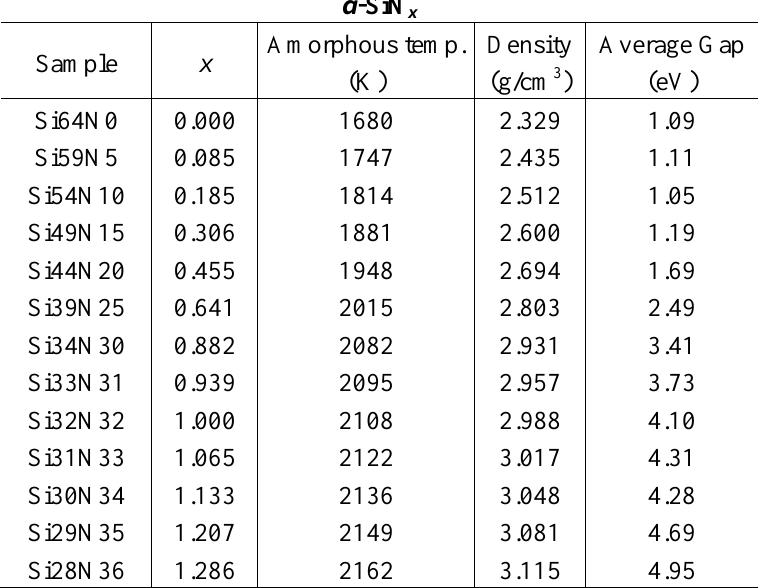
Table 2. Characteristics of 13 samples of amorphous silicon nitrogen alloys, each with 64 atoms total and with different nitrogen contents where 0 ≤ (number of N atoms) ≤ 36. The content is x = y /(64 − y ) where y is the number of randomly substituted